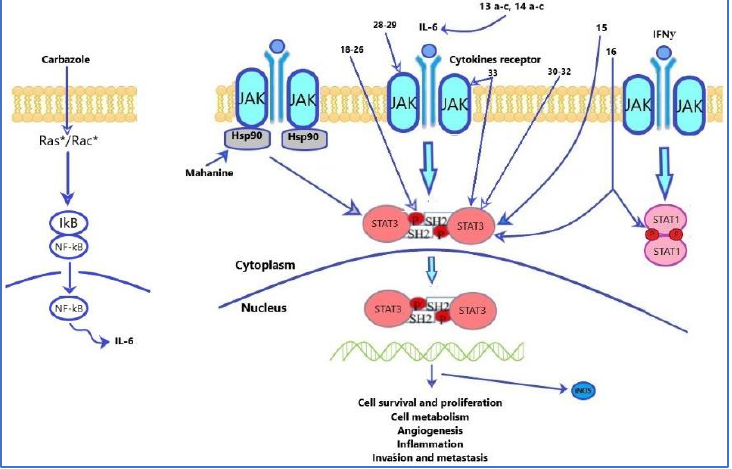
Figure 16. Mechanism of action of compounds carbazole mahanine and 13 a-c, 14 a-c , 15 , 16 , 18-26 , 28 , 29 , 30-33 .